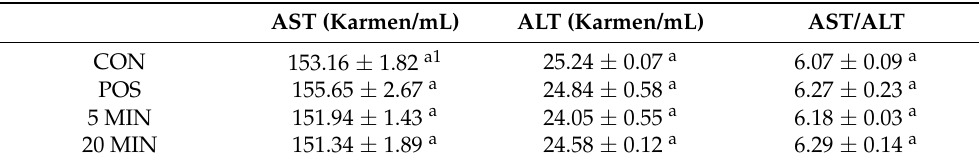
Table 8. Effects of basil essential oil and linalool inhalation on hepatotoxicity in chronically stressed rats. CON: chronic stress-exposed control group; POS: linalool (positive control) inhalation with chronic stress-exposed rats; 5 MIN: BEO inhalation for 5 min b chronic stress-exposed rats; 20 MIN: BEO inhalation for 20 min by chronic stress-exposed rats. AST (Karmen/mL) ALT